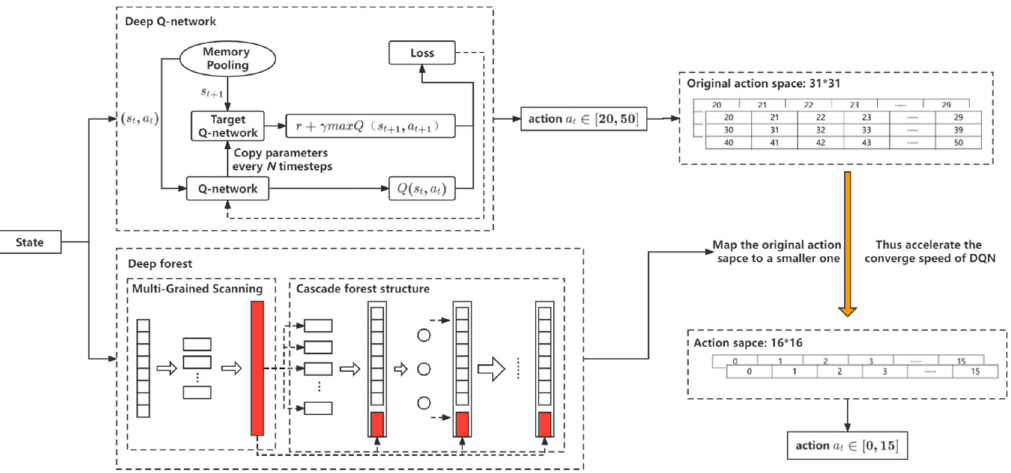
Figure 9. DF reduce action space.